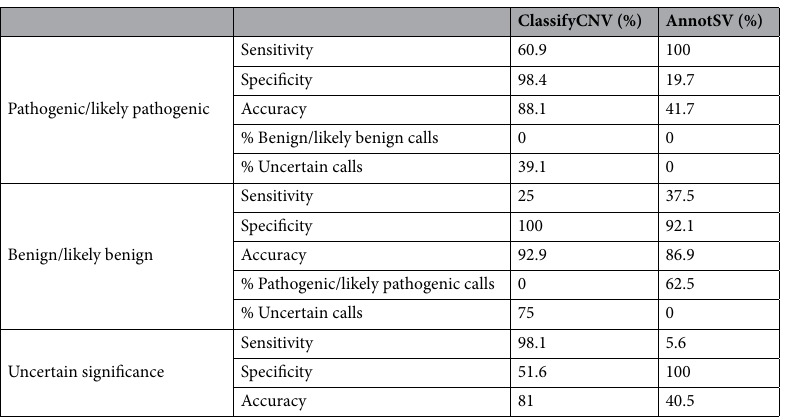
Table 3. A comparison of ClassifyCNV and AnnotSV. Both tools were tested on a set of 84 variants manually evaluated by ACMG/ClinGen. While ClassifyCNV produced a higher percentage of uncertain calls compared to AnnotSV, it had higher specificity and accuracy for pathogenic/likely pathogenic and benign/likely benign